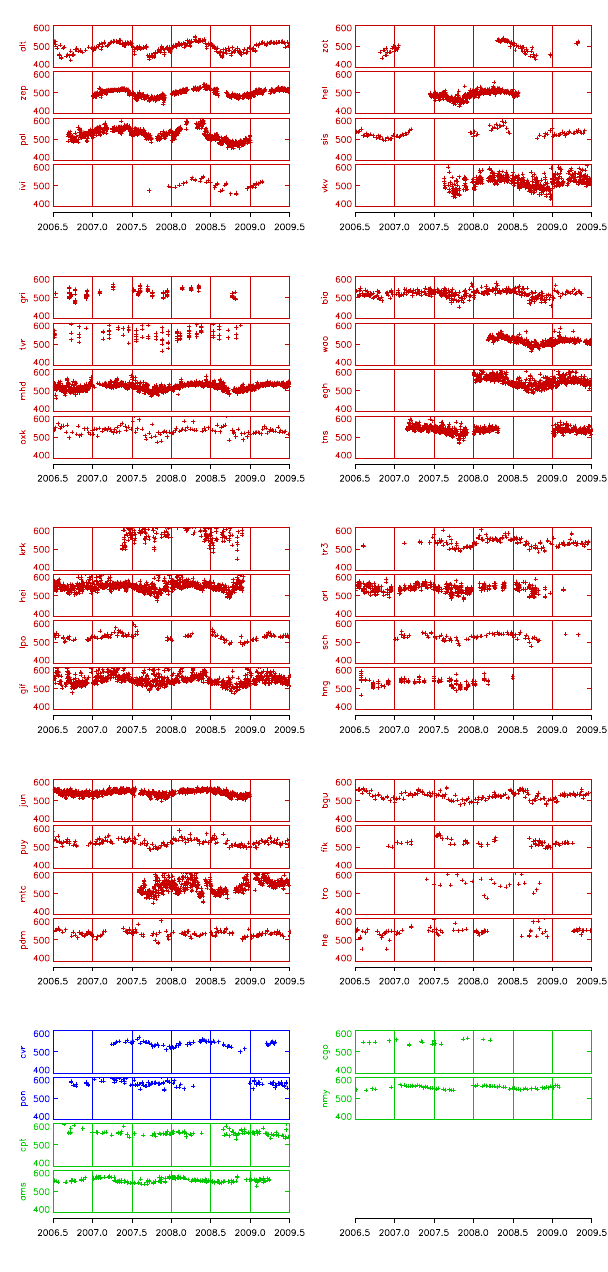
Fig. 2. H 2 time series of sampling sites from RAMCES and EUROHYDROS networks. Measurements are performed by 13 different European laboratories (see Table 1 and Table 2). The Northern Hemisphere sites are plotted in red, the tropical sites in blue and the Southern Hemisphere sites in green.